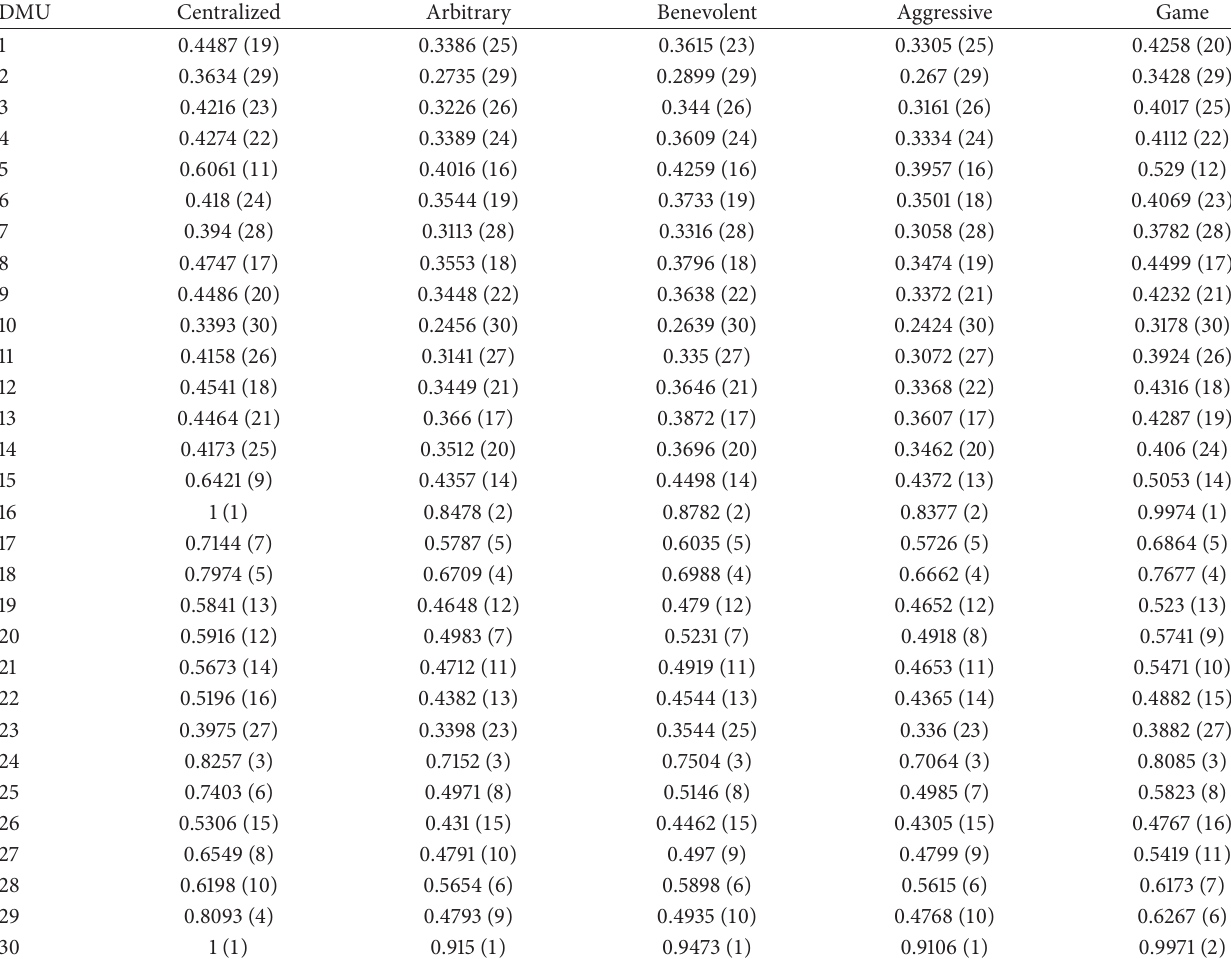
Table 1: Overall efficiencies from different models.